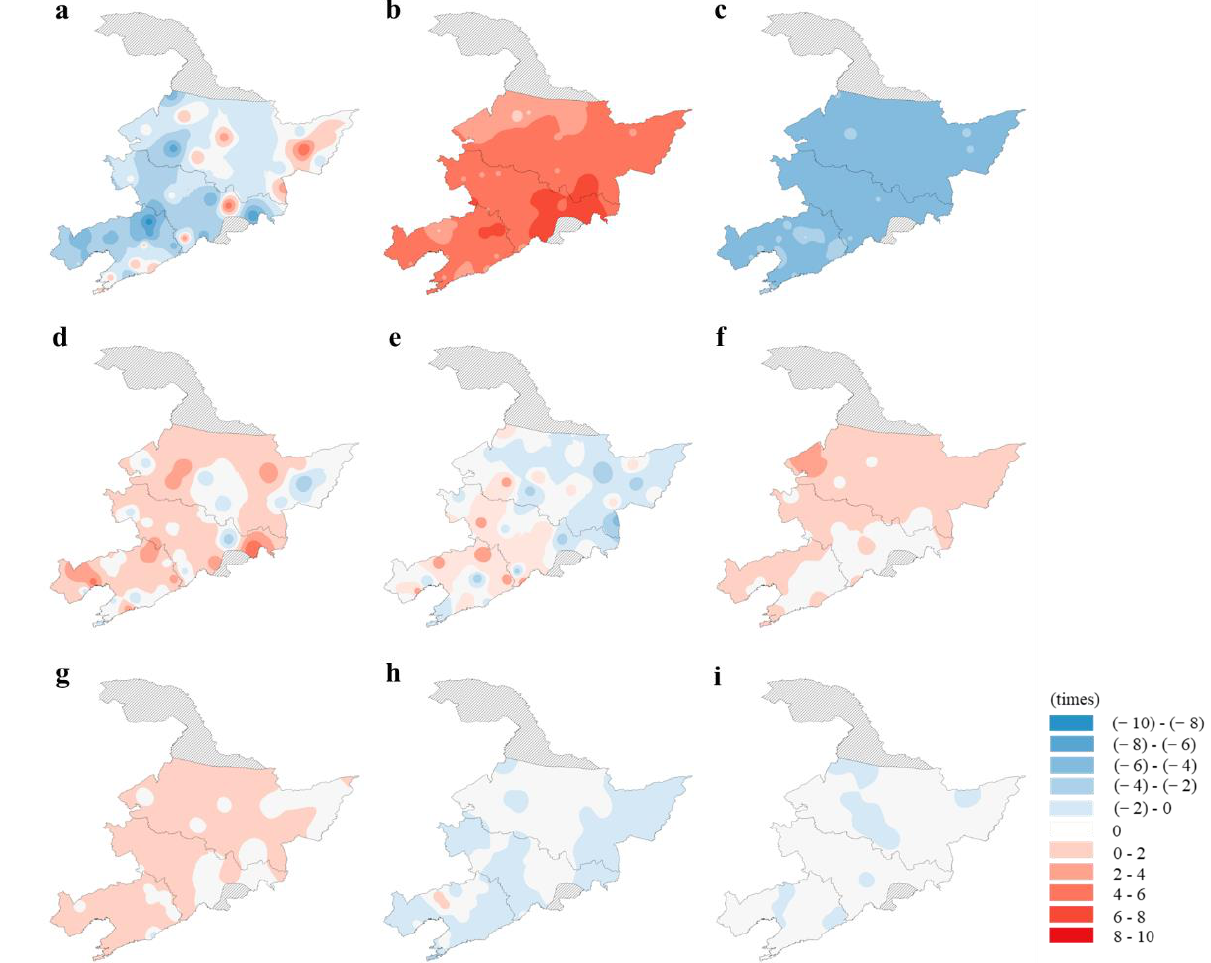
Figure 5. The difference in the frequencies of normal climate and climate extreme years in the two periods from 1960 to 2019 at 62 meteorological stations. (( a ) Normal-normal; ( b ) warm-normal; ( c ) cold-normal; ( d ) normal-humid; ( e ) normal-dry; ( f ) warm-humid; ( g ) warm-dry; ( h ) cold-humid; ( i ) cold-dry).